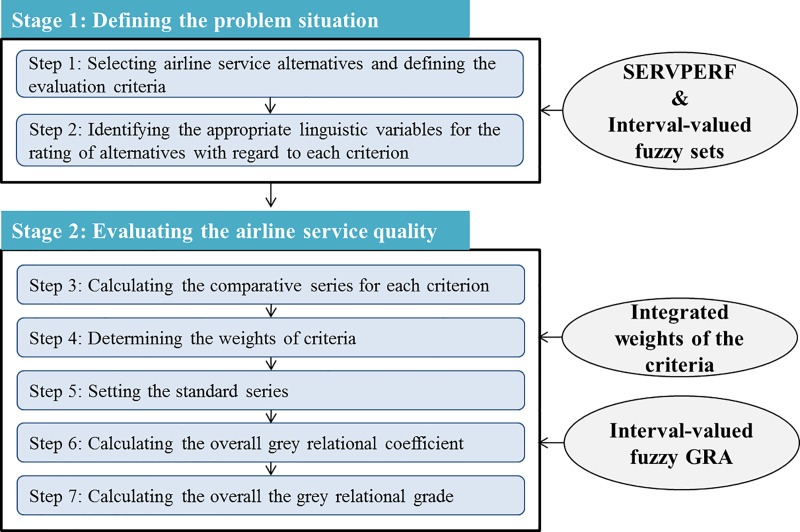
Overall framework.